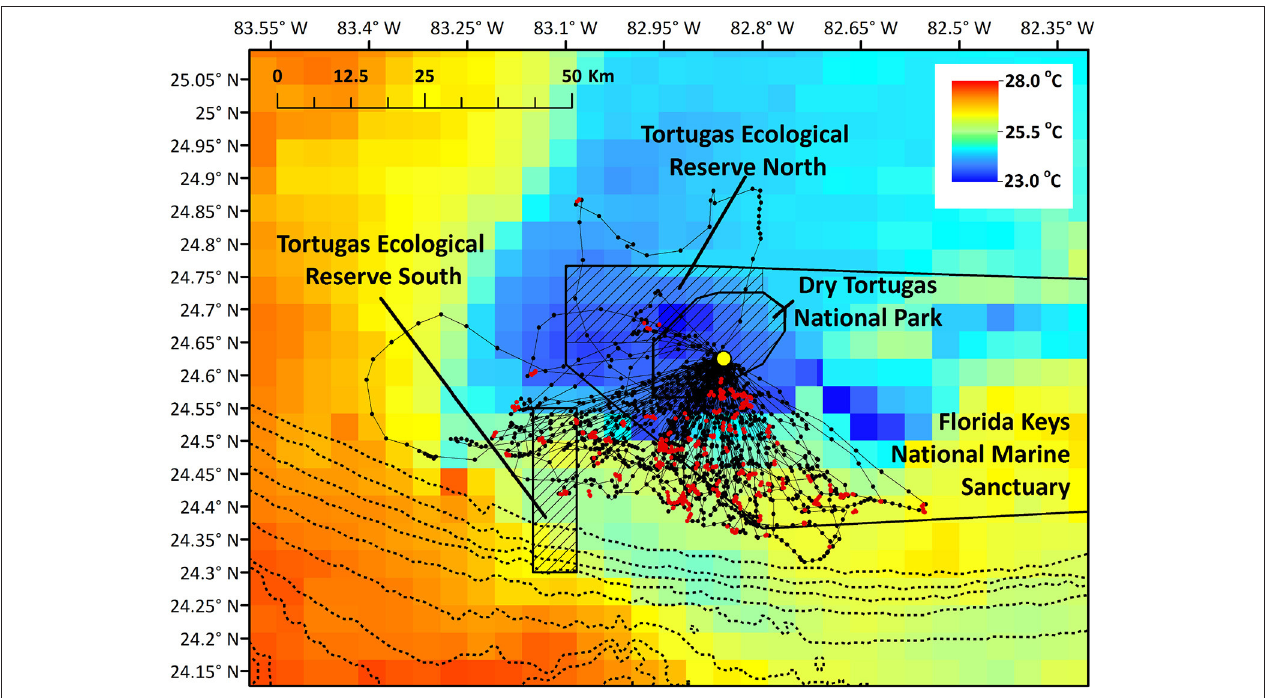
FIGURE 1 | Brown noddy tracks in relation to marine protected areas near the breeding colony and in relation to sea surface temperature ( ◦ C). Red locations indicate locations where birds had high-residence time, while black locations indicate low-residence time locations. Hashed areas indicate no-take areas (Dry Tortugas National Park and the two Florida Keys National Marine Sanctuary Ecological Reserves), and the dotted line closest to the park indicates the 100m bathymetry contour, and depth contours grow deeper by 100m moving east to west. Yellow point indicates the nesting colony on Bush Key.